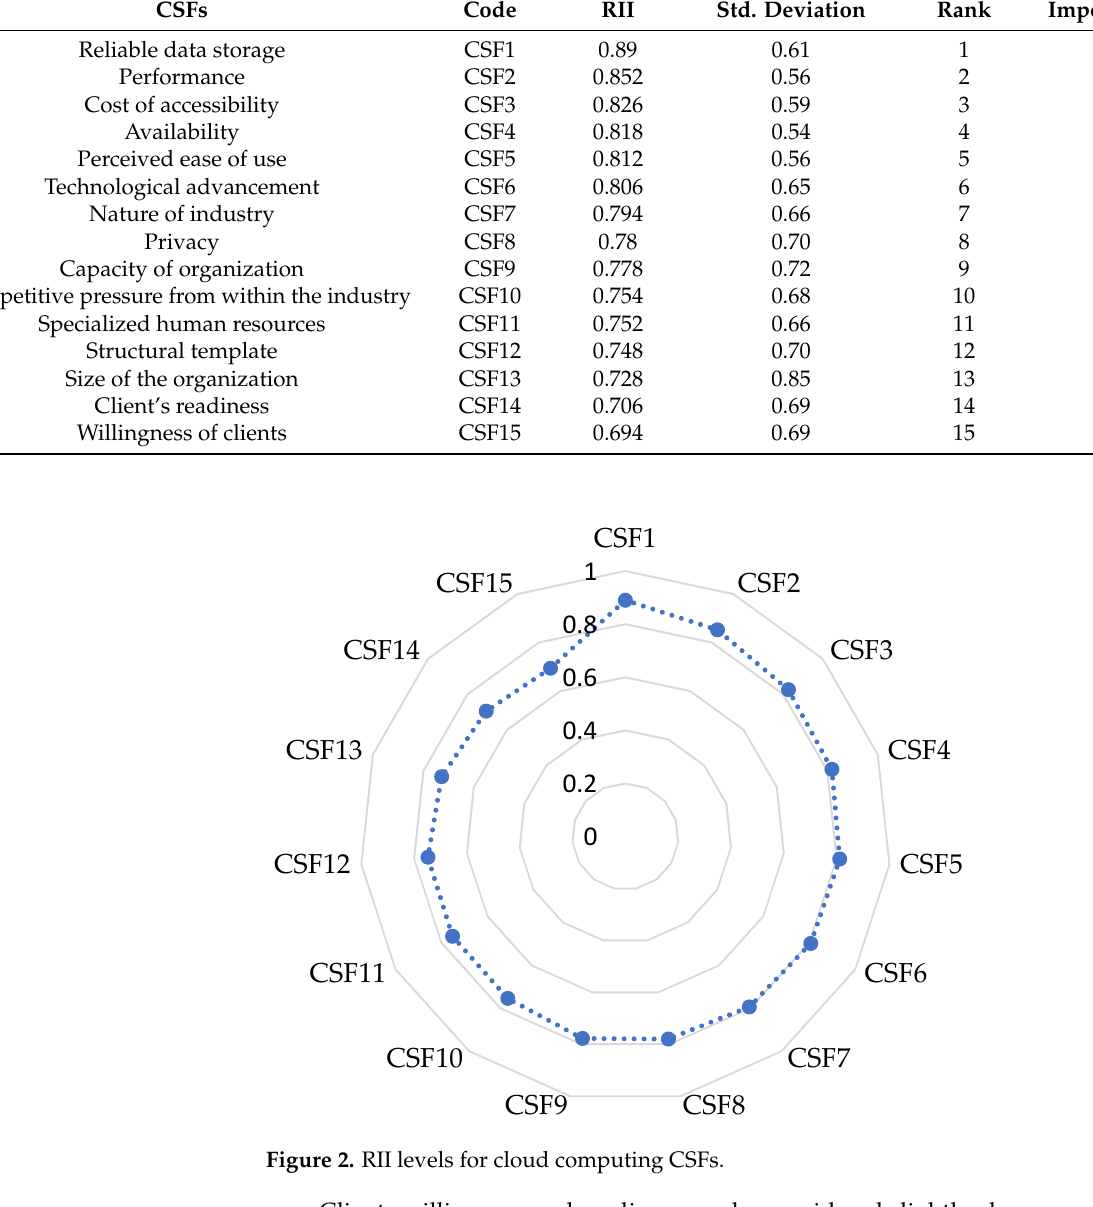
Table 4. KMO and Bartlett's test result related to VM activities. KMO and Bartlett's Test Kaiser–Meyer–Olkin measure of sampling adequacy.